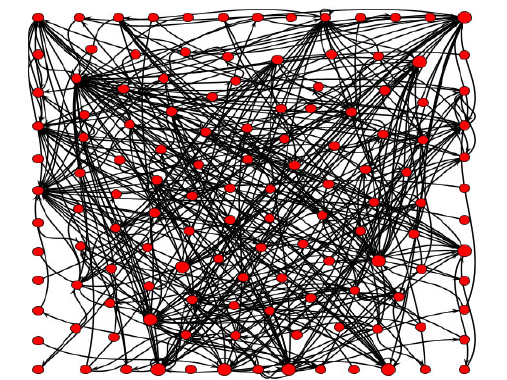
Figure 6 . Visualization for Moodle Discussion—Week